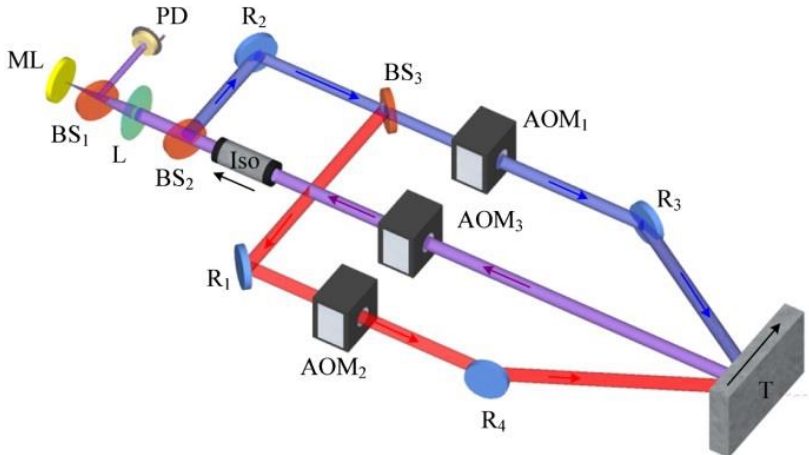
Figure 7. Schematic diagram of the 2-D displacement measurement system. ML is the microchip laser; BS 1 , BS 2 , and BS 3 are the beam splitters; L is the optical lens; AOM 1 , AOM 2 , and AOM 3 are the acousto-optic modulators; R 1 , R 2 , R 3 , and R 4 , are reflectors; Iso is the optical isolator; T is the target; and PD is the photodetector. (Figure reproduced from Ref. [14]).